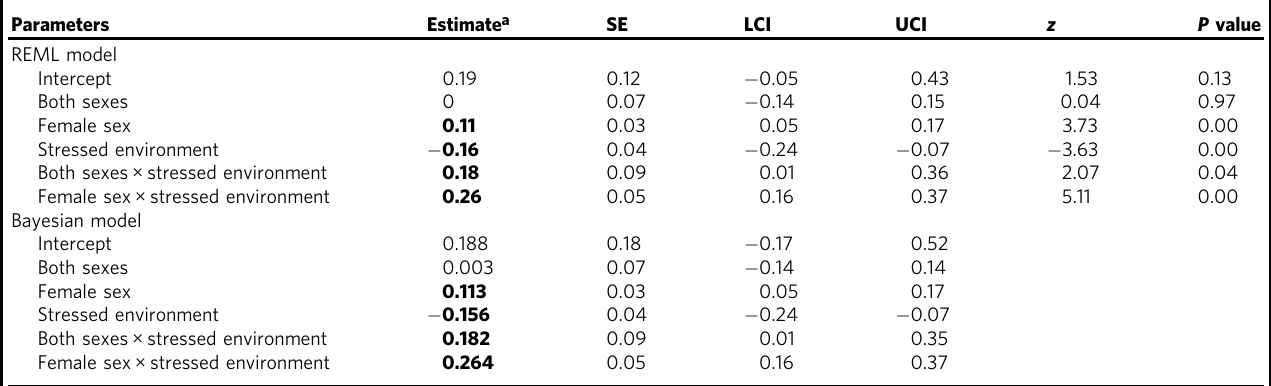
Table 1 Multilevel meta-analysis model results Parameters